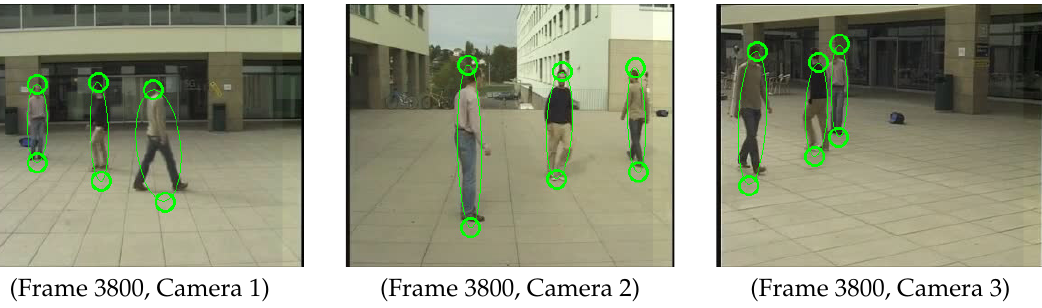
Figure 15. Detected feet and head positions of Camera Network 3. Green circles represent detected positions using ellipse fitting.